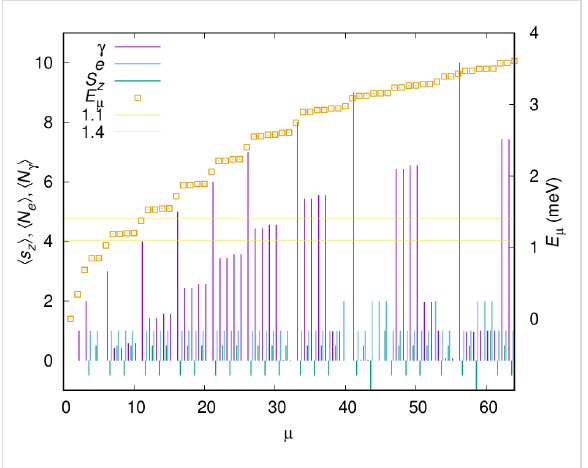
Figure 2: The energy spectrum (gold squares) for the interacting closed central system for plunger gate voltage V g = 1.6 mV and photon energy = 0.343 meV as a function of the state number μ . The elec- tron and photon content, and z -component of spin is indicated with vertical bars for each many-body state. The chemical potential of the left ( μ L ) and right ( μ R ) leads is shown in relation with the spectrum. B ext = 0.1 T, L x = 180 nm, = 2.0 meV, and g EM = 0.05 meV. An x -polarized cavity photon field is assumed. The photon energy = 0.343 meV coupling the two lowest